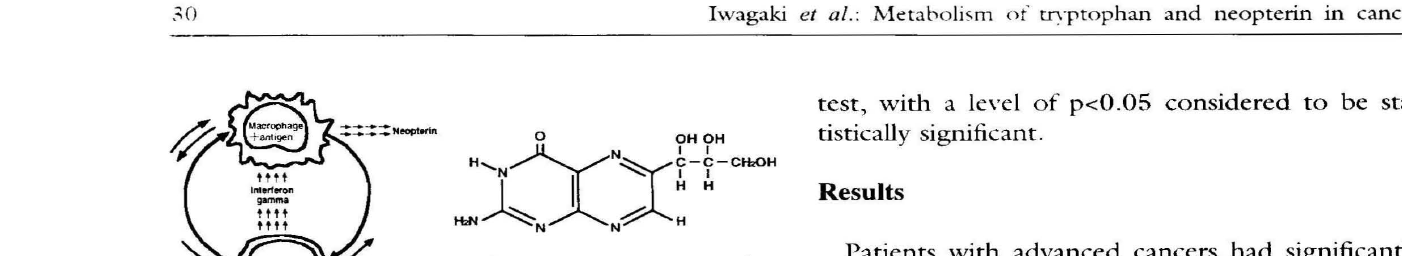
Figure 1. The interaction of T-cell and macrophages.